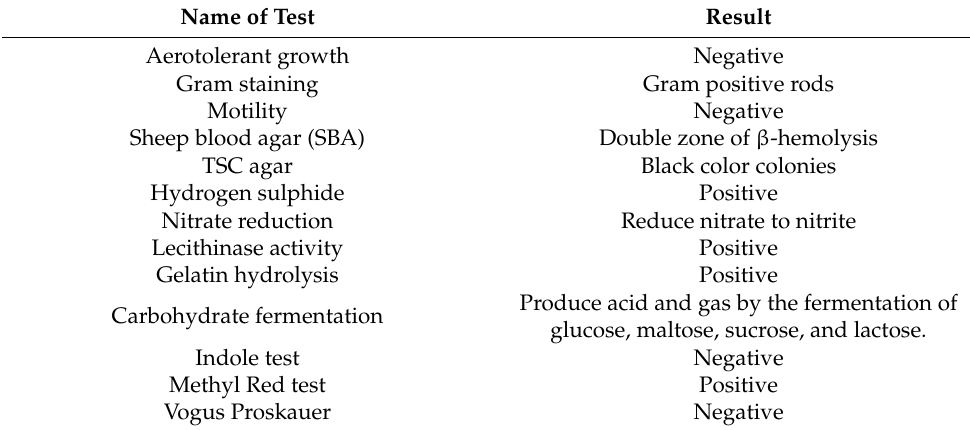
Table 3. Biochemical characteristics of C. perfringens